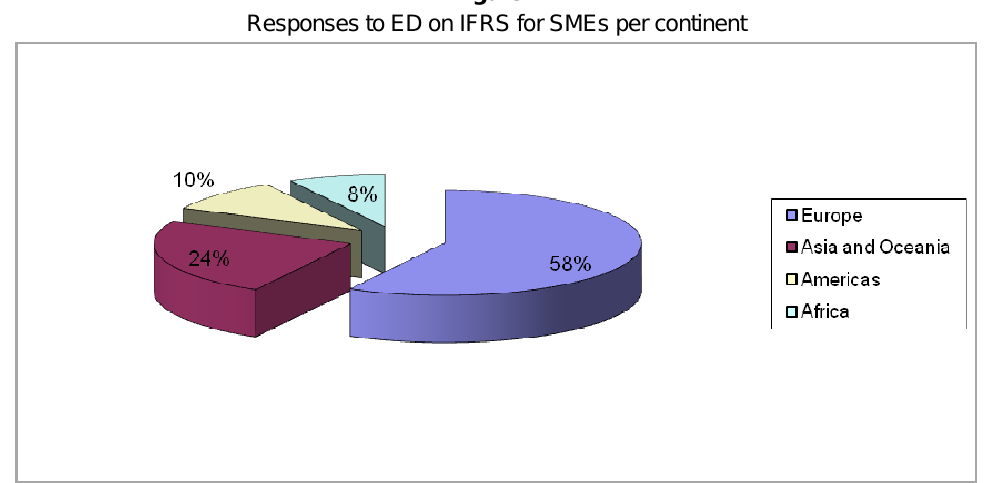
Responses to ED on IFRS for SMEs per